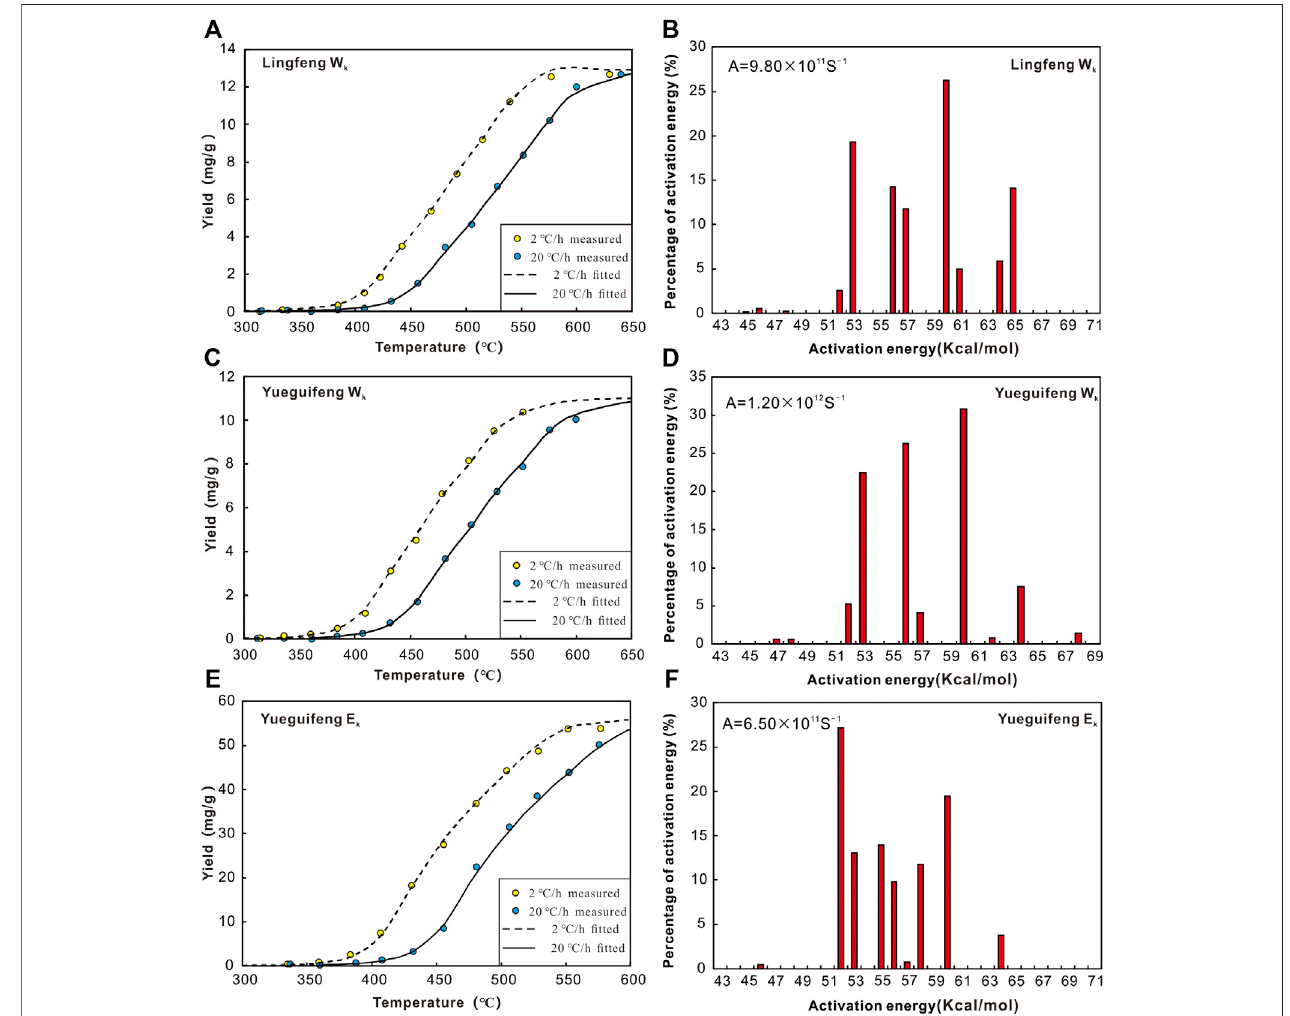
FIGURE 4 | Fitting results of natural gas yield and distribution of activation energy for hydrocarbon generation of the source rocks in the Lishui Sag. A (cid:2) frequency factor.